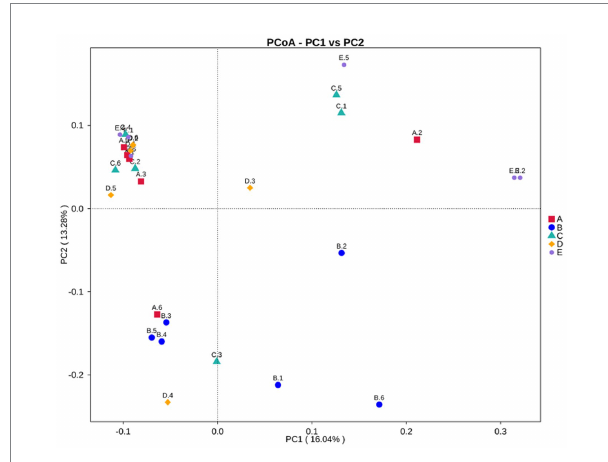
FIGURE 1 The beta diversity of the cecal microbiota in laying hens fed the 5 experimental diets using principal component analysis (PCoA). There were 6 replicates (birds) in each treatment ( n = 6). Group A (A.1-A.6): 0 g/t rare earth diet; Group B (B.1-B.6): 150 g/t rare earth diet; Group C (C.1-C.6): 300 g/t rare earth diet; Group D (D.1-D.6): 450 g/t rare earth diet; Group E (E.1-E.6): 600 g/t rare earth diet. To test the significant differences in beta diversity of bacterial communities among treatment groups, PERMANOVA (Adonis procedure with 999 permutations) was conducted to calculate p value s. There were significant differences between Group A and Group E ( R 2 = 0.191, p = 0.002), Group B and Group E ( R 2 = 0.201, p = 0.004), Group C and Group E ( R 2 = 0.153,